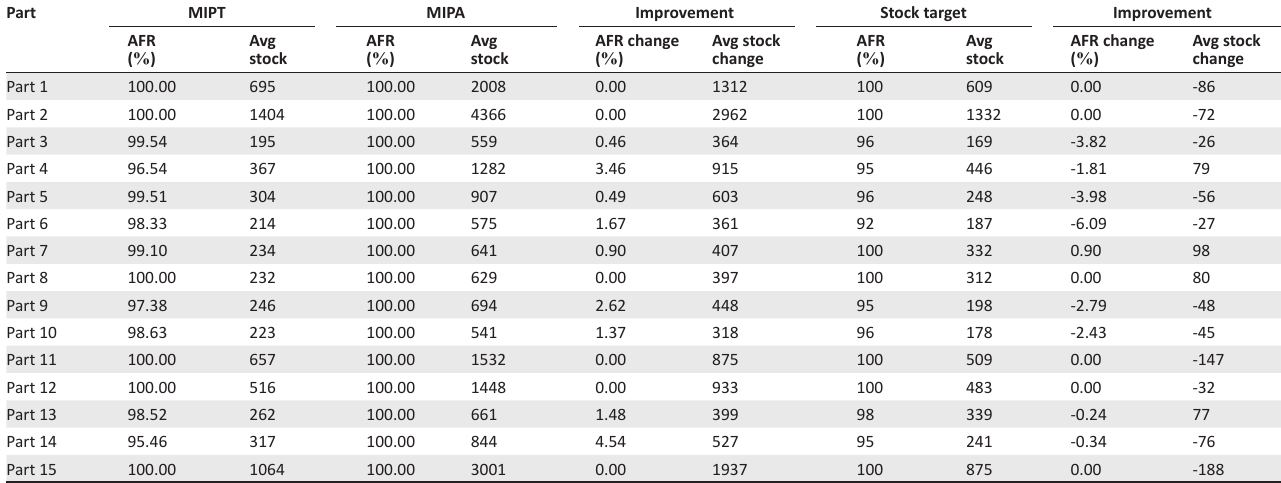
TABLE 5: Results of simulating actual demand data for medium and slow moving import parts.